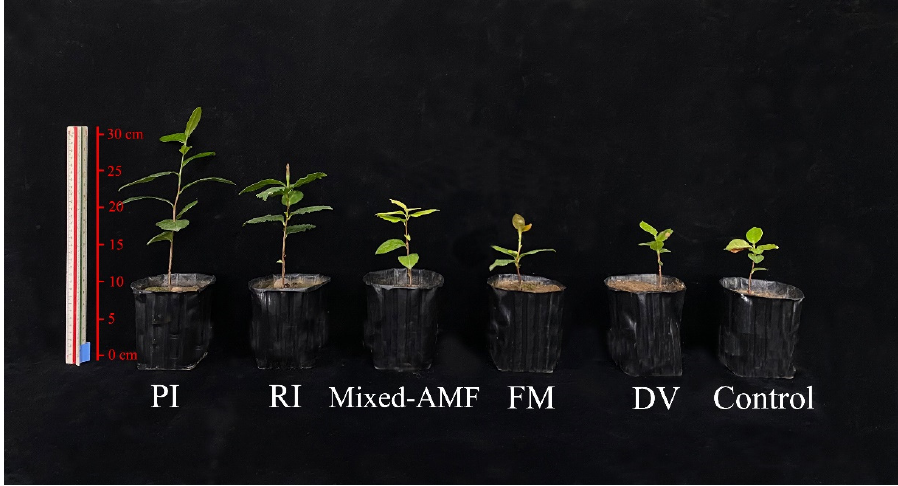
Figure 1. Changes in plant growth of Camellia oleifera plants after inoculation with symbiotic fungi. The abbreviation is the same as Table